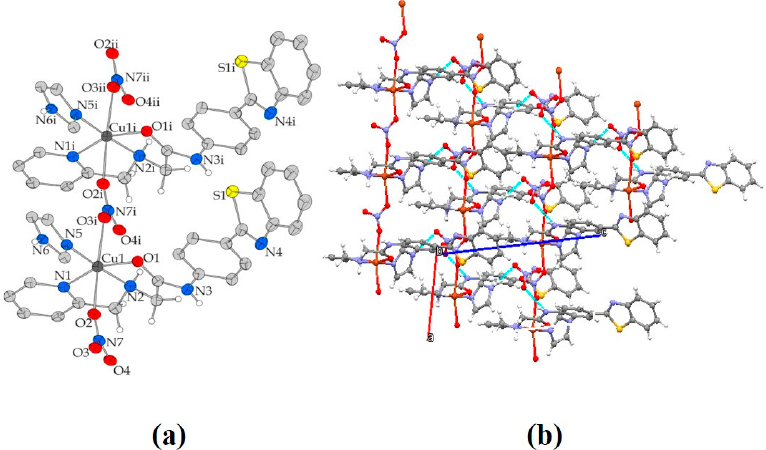
Figure 2. ( a ) The molecular structure of complex Cu-1 indicating the polymeric chain formation. Counterions and aromatic hydrogen atoms have been omitted for clarity. Thermal ellipsoids were drawn with 40% probability; ( b ) hydrogen-bonding interactions (in blue dotted lines) in complex Cu-1 .